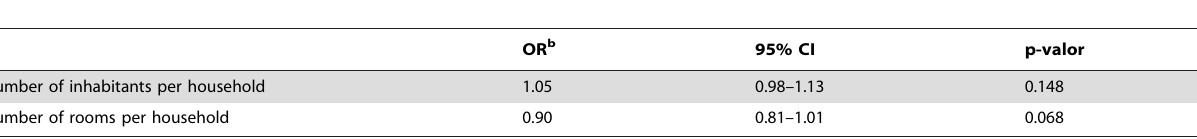
Table 5. G. duodenalis infection in children in Northeast region of Minas Gerais State, Brazil, 2009–2010; continuous variables selected in the univariate analysis a